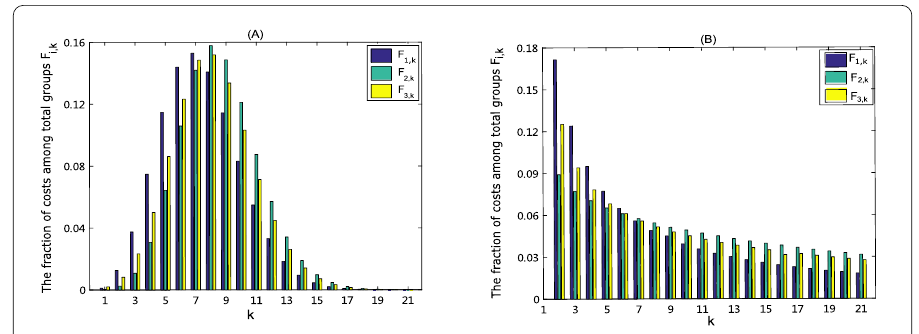
Figure 6 The distribution of each control costs among total groups in the random network ( A ) and SF network ( B ), which is illustrated by the fraction F i , k =